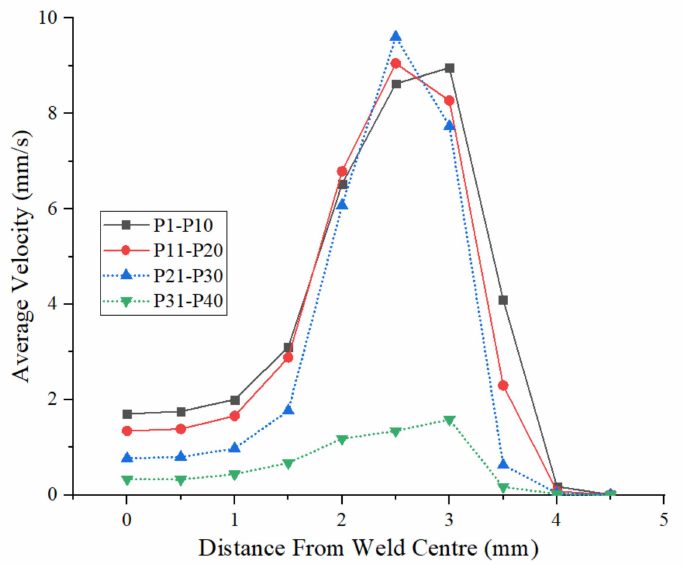
Figure 14. Average velocities of the points (P1–P40), located for material flow